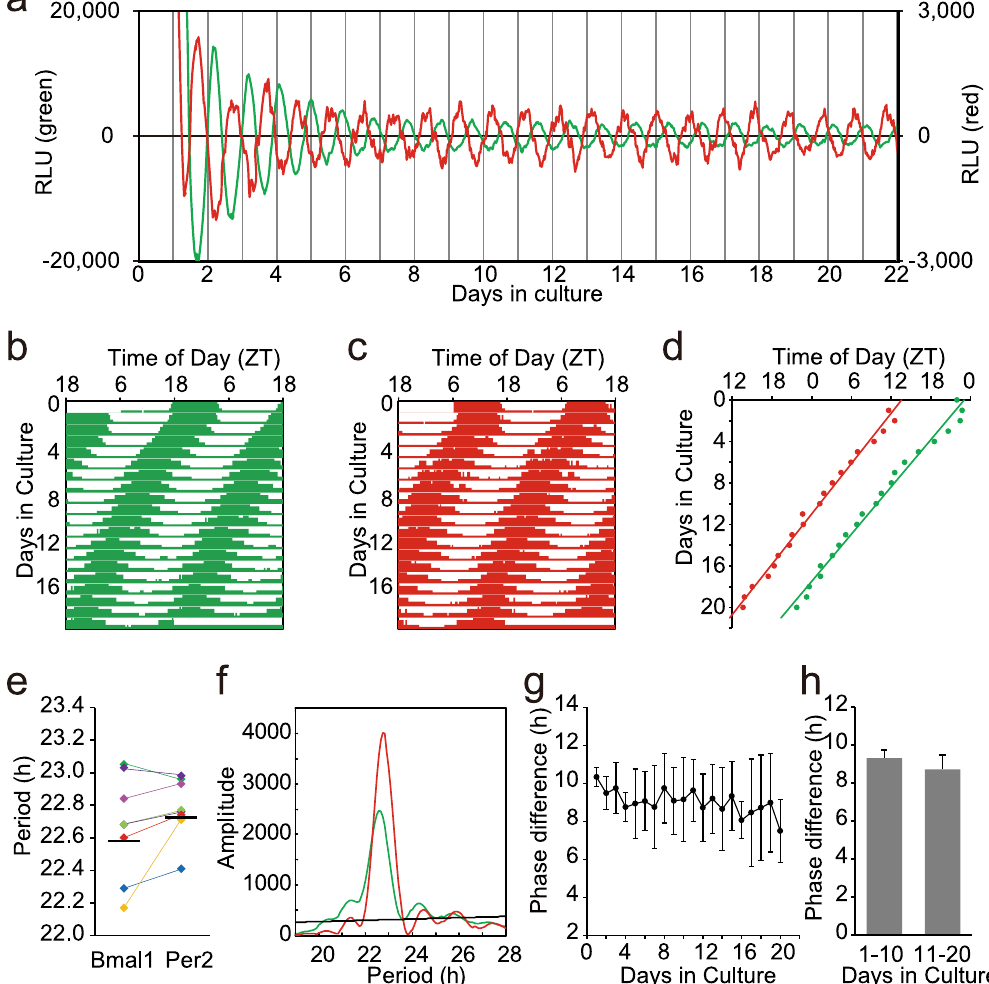
Figure 2. Circadian rhythms of the adult SCN slices of Bmal1-Eluc:Per2-SLR2 mice ( a ) Sequential records of circadian Bmal1 (green) and Per2 (red) rhythm in an adult SCN slice. See also the legend for Fig. 1a. ( b , c ) A double plotted circadian Bmal1 (green) and Per2 (red) rhythm in a raster format. ( d ) Successive plots of circadian peak phases ( Bmal1 , green; Per2 , red) and regressions lines fitted to them in the same SCN slice as used in ( a ). ( e ) Circadian periods of Bmal1 and Per2 rhythms in the cultured SCN (n = 8) calculated from a regression line. See also the legend for Fig. 1e. ( f ) Chi-square periodogram demonstrates significant but different circadian periods of Bmal1 (green) and Per2 (red) rhythm. See also the legend for Fig. 1f. ( g ) A phase difference ( ψ ) between the circadian Bmal1 and Per2 peaks in each cycle. See also the legend for Fig. 1g. ( h ) The mean and SD of ψ in the first and the last 10 cycles is